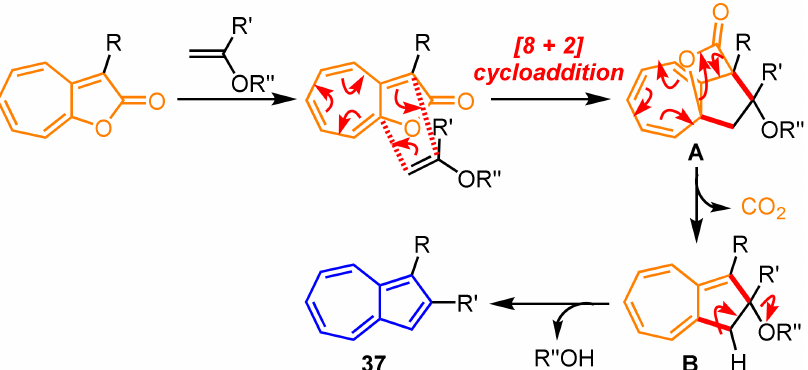
Scheme 13. Reaction mechanism for the formation of azulene derivatives 37 by the reaction of 2 H -cyclohepta[ b ]furan-2-ones with enol